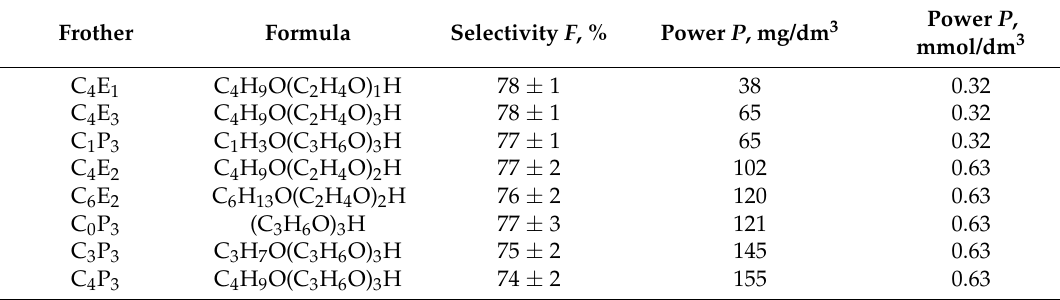
Table 15. Selectivity F and power P of alkyl polypropoxy C n P m and polyetoxy C n E m frothers used for flotation of copper ore [76].